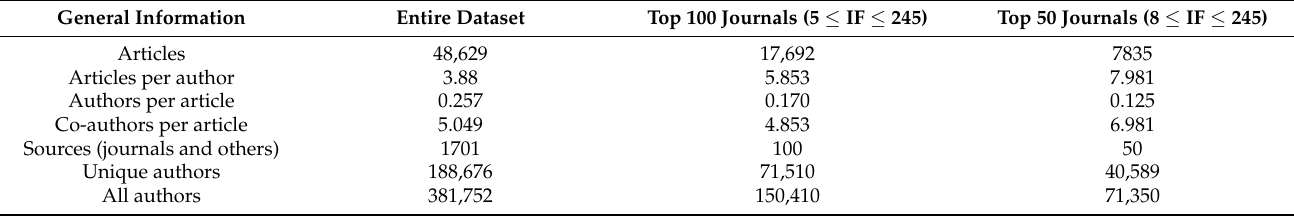
Figure 1. PRISMA flow diagram of the selection of studies to be included in the meta-analysis during the period ranging from 2000 (Q1) to 2021 (Q1). Table 1. General information on articles related to “cancer nanotechnology” published in the period ranging from 2000 to 2021. Data is given based on the number of unique authors (from a total of 381,752 non-unique authors as each author can have more than one